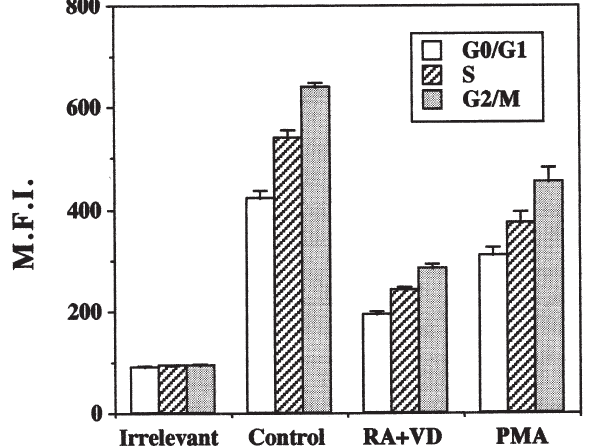
Fig. 5. Flow cytometric detection of proteasomal subunit p30/33K in the different phases of the cell cycle of non-induced and 72 h RA+VD and PMA-induced cells. The subunits detection is linearly correlated with the DNA